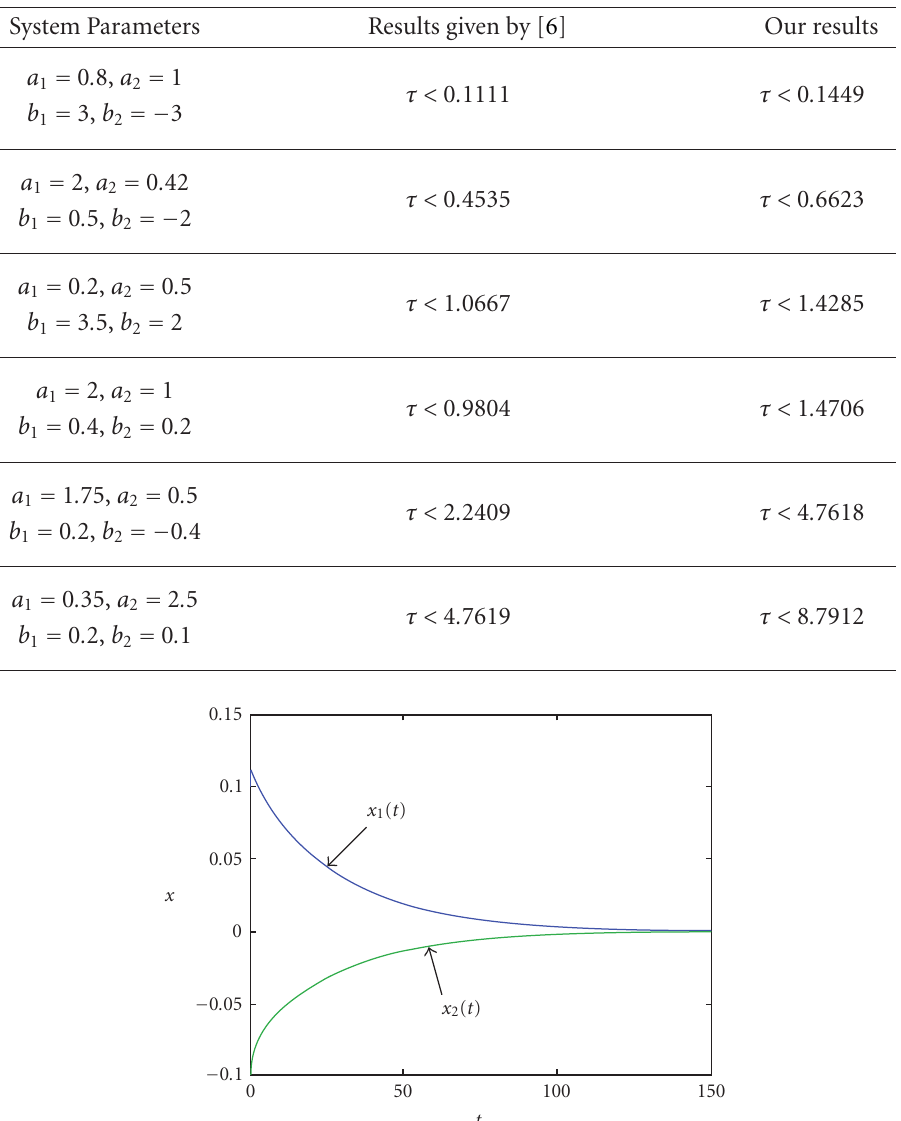
Table 4.1. A comparison of the delay-dependent stability criteria when σ = 0 . 5 τ .